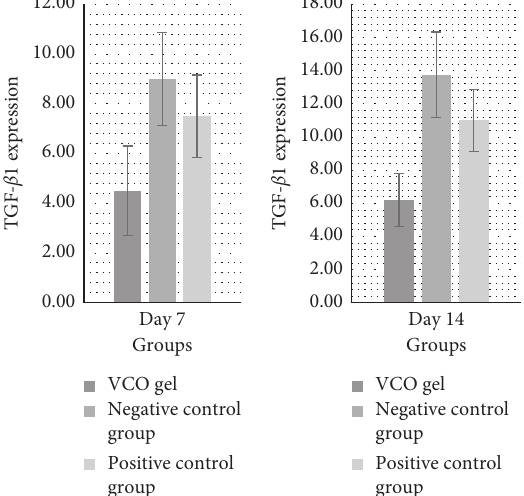
Figure 4: Chart bars showing TNF- α expression from the three groups on the 7th and 14th